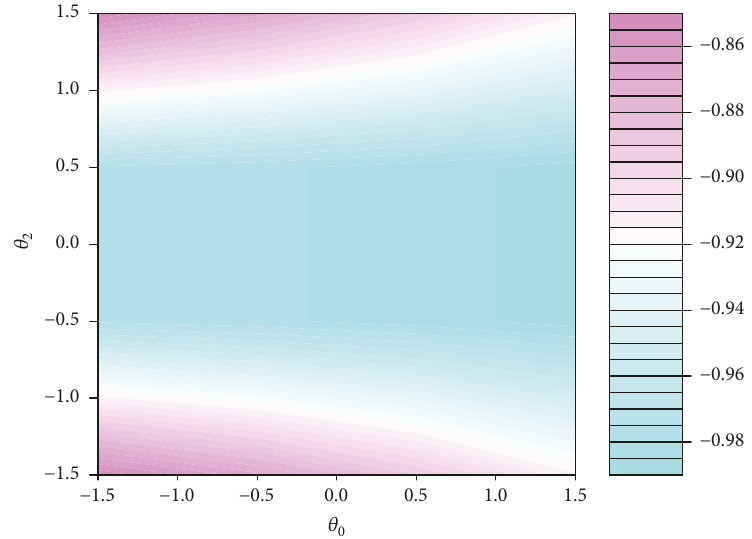
Figure 2: Contour plot of 𝛽 ∗ 4 under